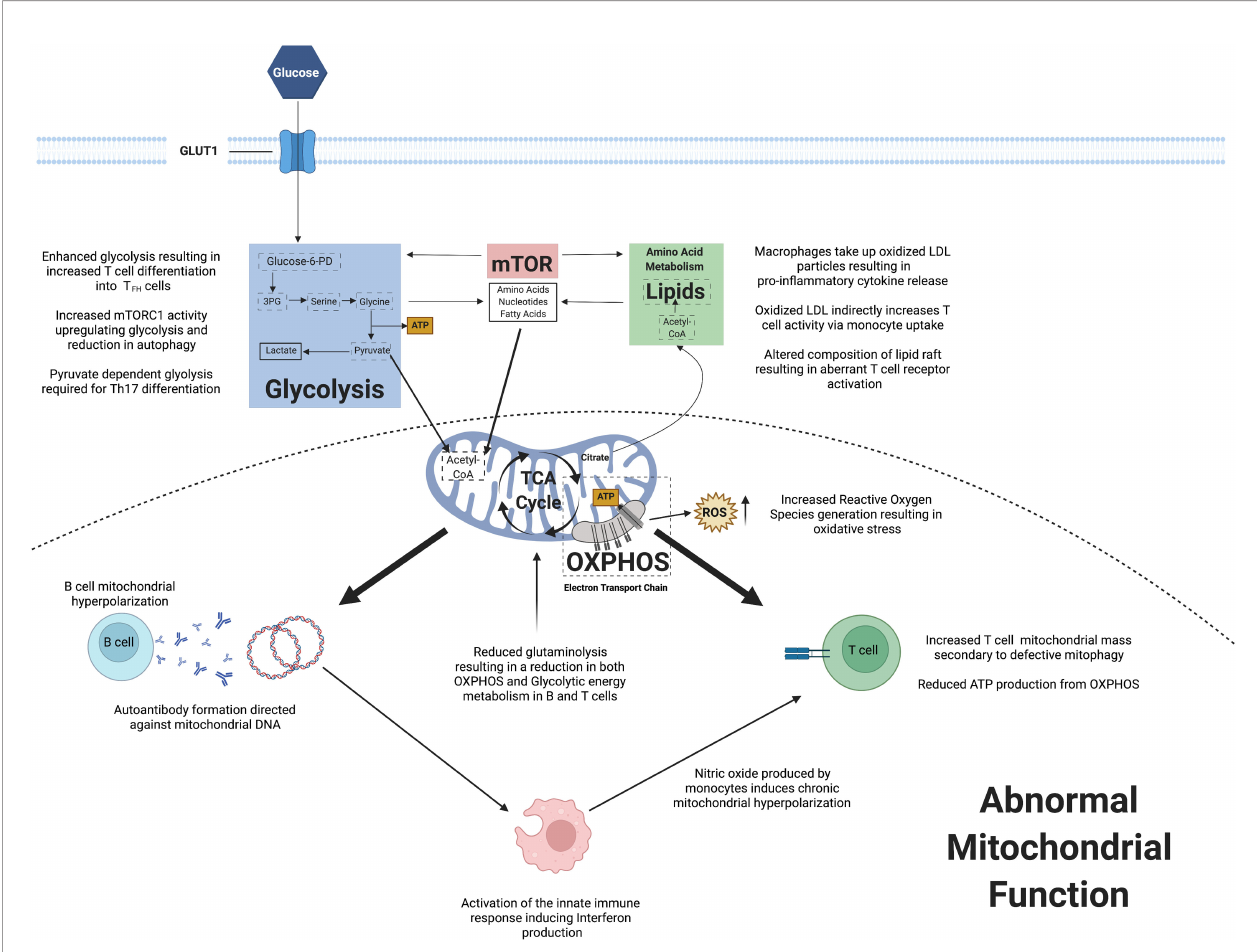
FIGURE 2 | A summary of observed changes in cellular metabolism reported in systemic lupus